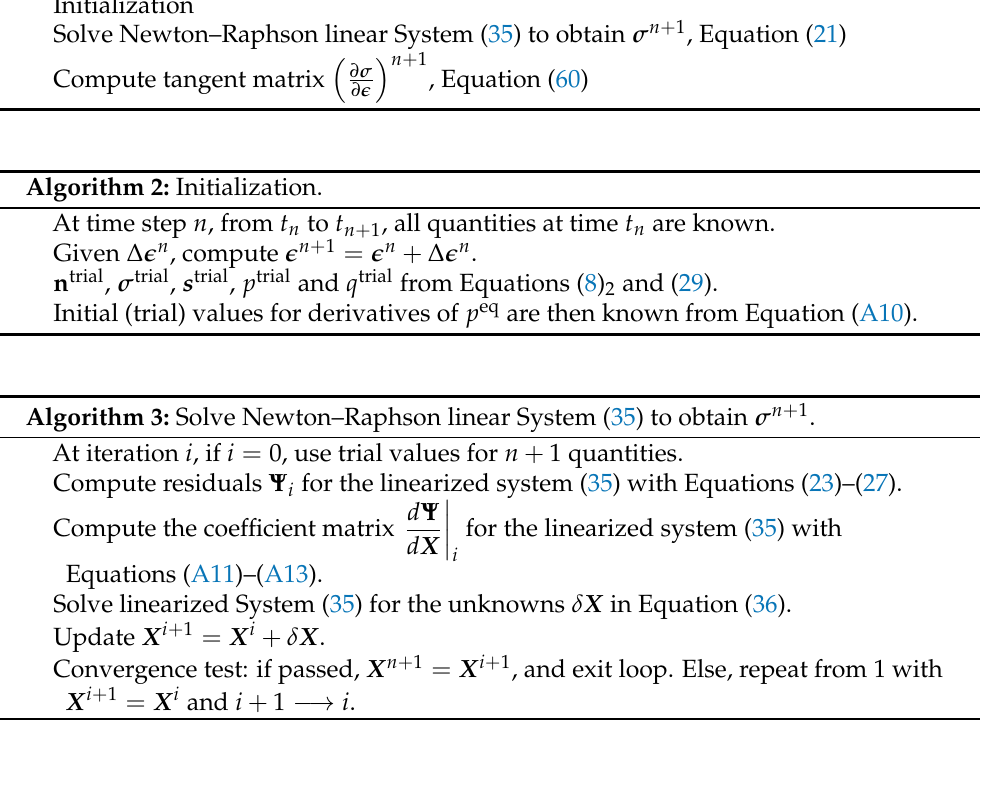
Algorithm 1: Implicit backward difference time integration. Initialization